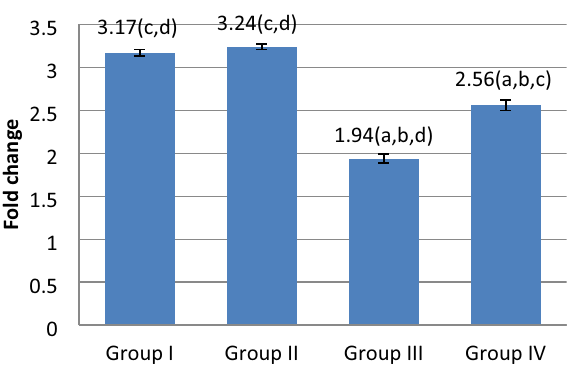
Figure 1. Effect of FUC treatment on NrF2 mRNA gene expression. values are represented as mean ± SD. Data are represented as mean ± SD. Statistical analysis was carried out using one-way ANOVA with Tukey’s post hoc test, SPSS computer program. a–d Significant difference between groups at * p < 0.05. a Significance from group I; b significance from group II; c significance from group III; d significance from group IV. Degree of freedom is (3) between groups and (24) within groups (total = 27).